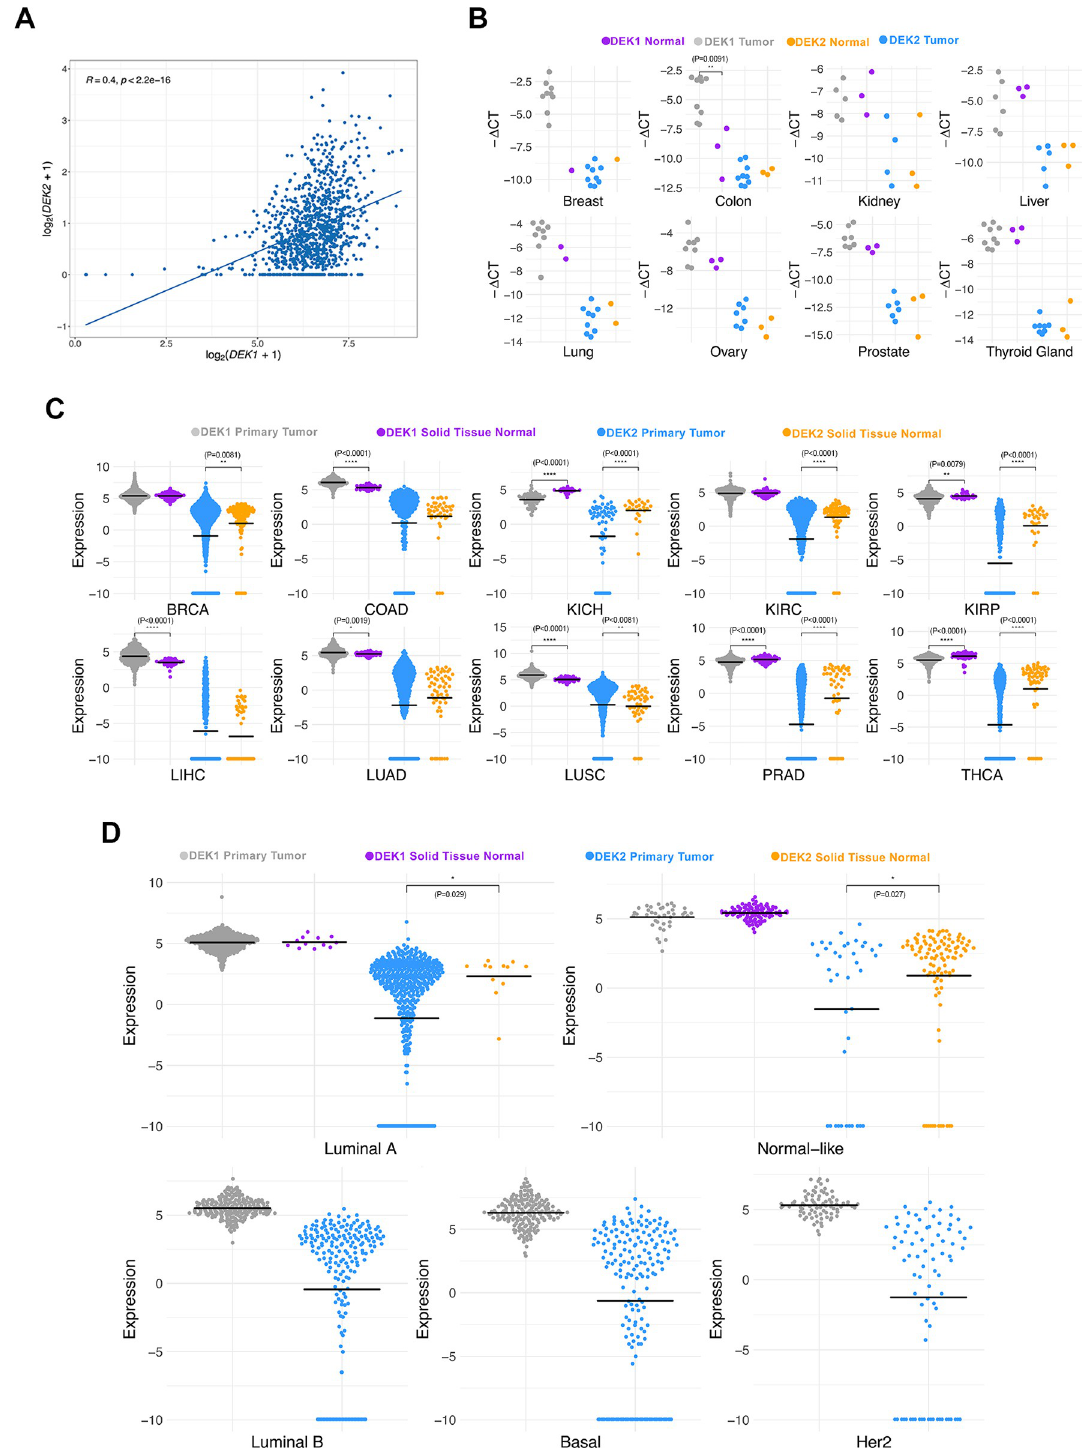
Fig 6. The mRNA expression profiles of DEK1 and DEK2 . A) CCLE dataset; B) Tissue array panel; and C, D) TCGA datasets. DEK1 and DEK2 Ct values were normalized to ACTB (tissue array) and reported as - Δ Ct while CCLE and TCGA dataset transcript values were transformed as log2(RSEM+1) and log2(RSEM TPM+1), respectively. The Mann-Whitney U Test was used for statistical analysis. Asterisks represent the statistical significance.